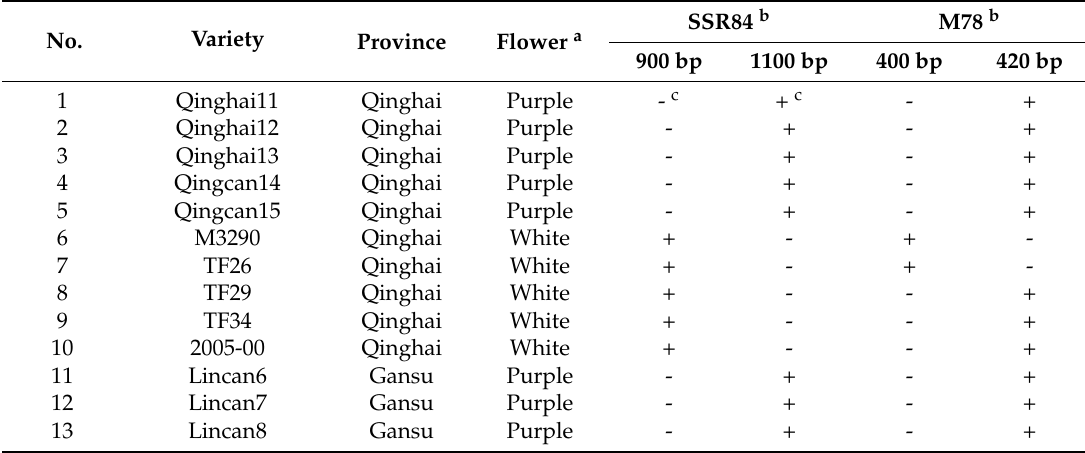
Table 3. The 34 Chinese faba bean genotypes used for validation of the closely linked